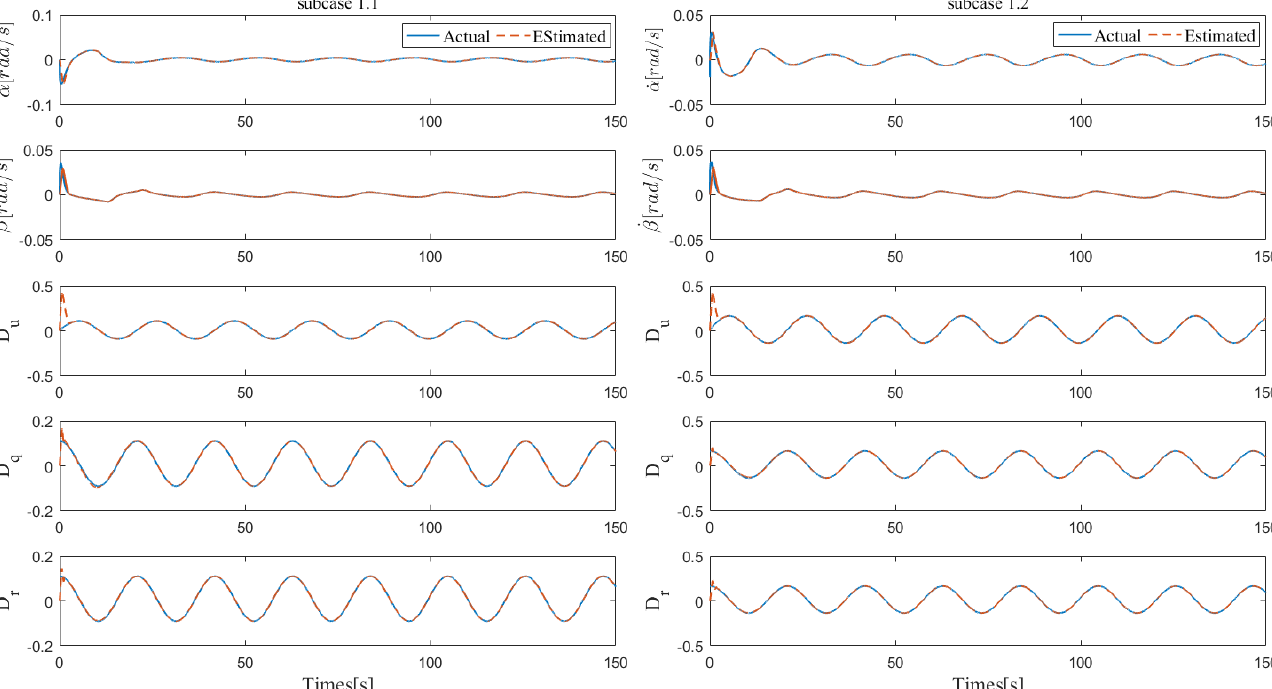
Figure 5. Disturbance estimations of subcases 1.1 and 1.2.